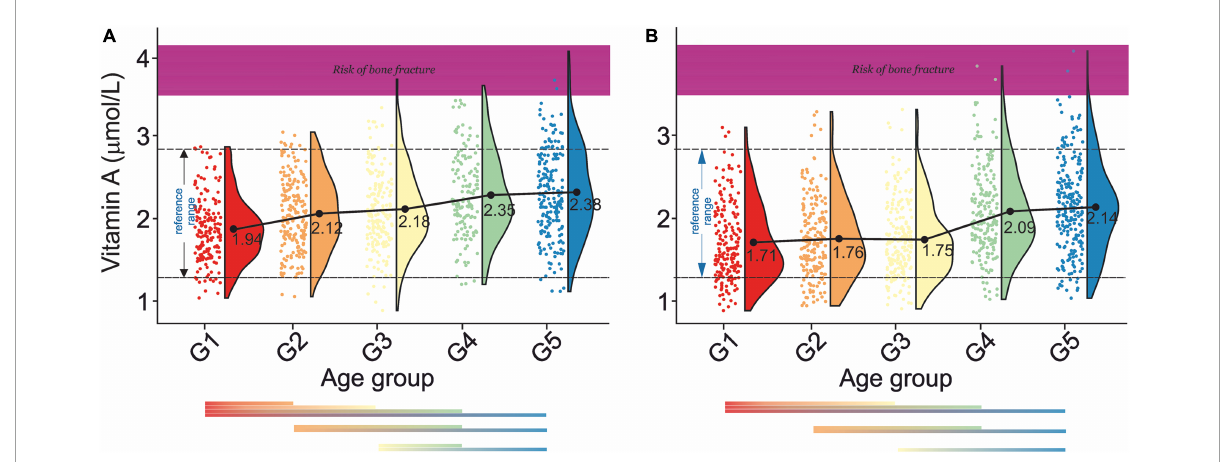
FIGURE3 Rain-cloud plots of age-dependent changes in vitamin A levels as a function of age group G1: 20 ≤ 1 < 30, G2: 30 ≤ 2 < 40, G3: 40 ≤ 3 < 50, G4: 50 ≤ 4 < 60, and 60 ≤ G5 < 70 years of age-stratified by gender (A) men, (B) women. Mean values for a specific sample are truncated to one decimal place. Color bars refer to statistically significant differences between groups at P < 0.05. Shaded area corresponds to vitamin A levels at which an increased risk of bone fracture is observed (98).